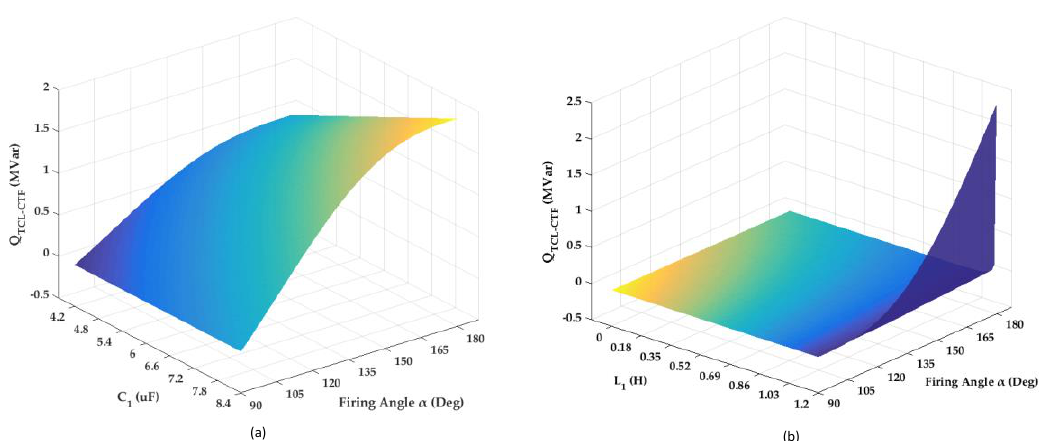
+ , C 1 , L 1 , and α . In ( a ), the varying between the C 1 and α TCL _ CTF